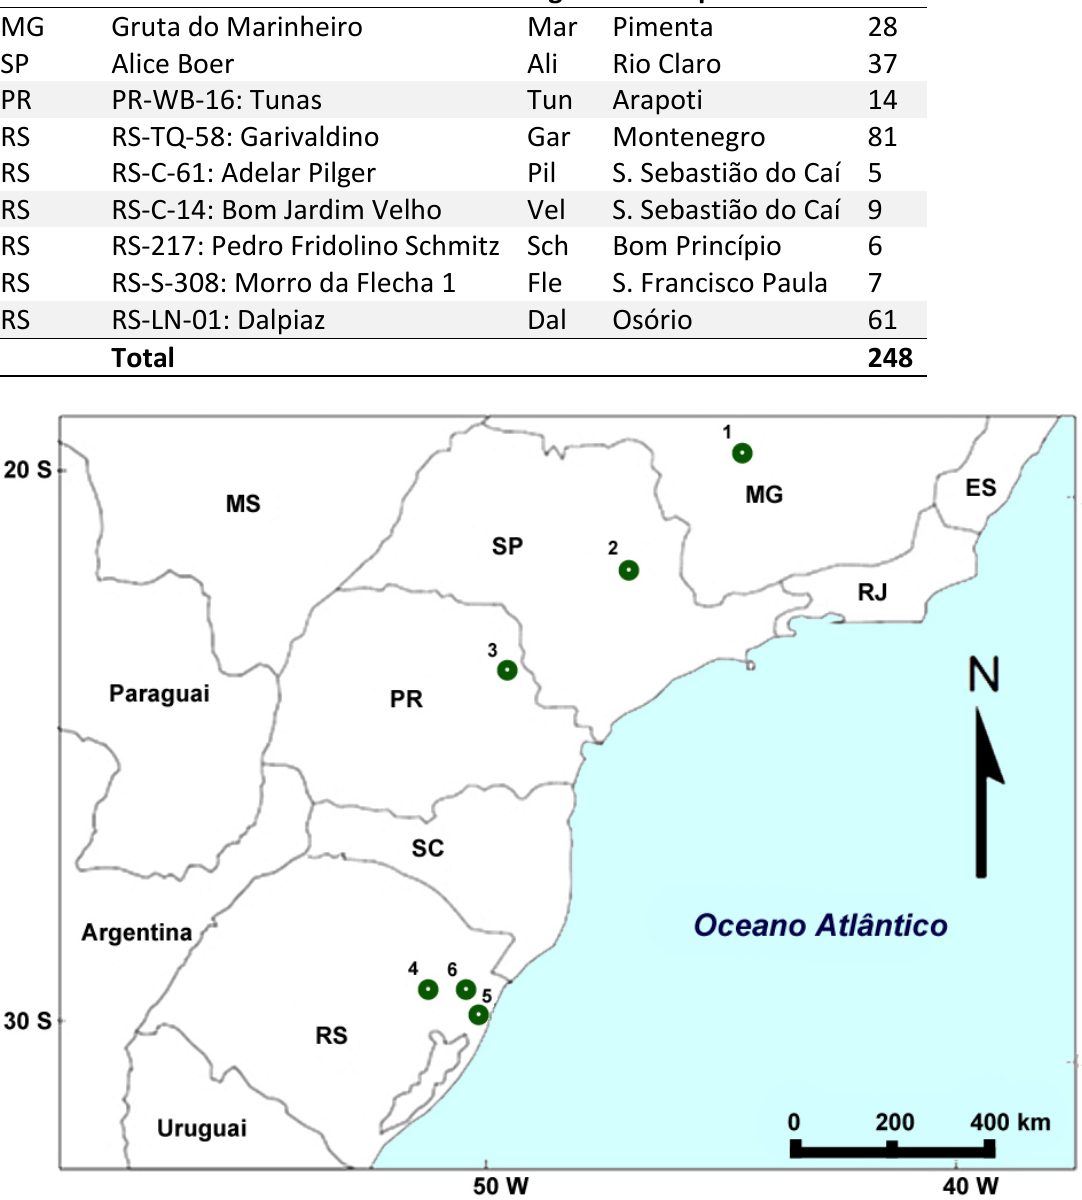
Figura 2. Mapa apresentando a localização dos sítios arqueológicos. Figure 2. Map indicating the locations of archaeological